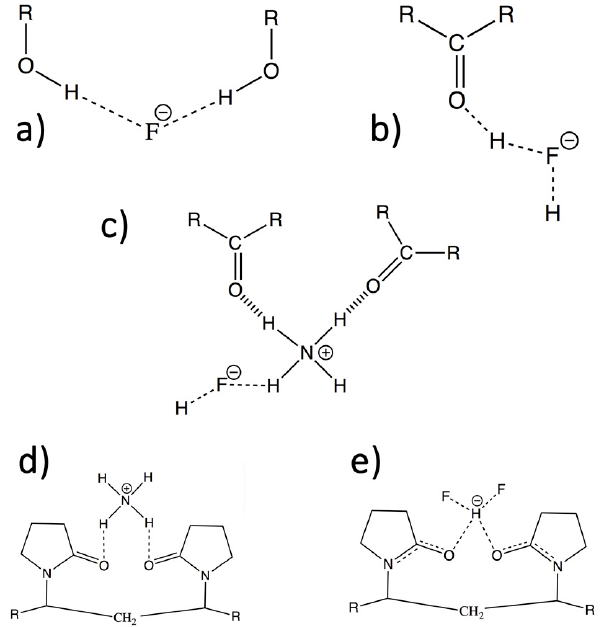
Figure 1. A selection of possible coordination geometries of fluoride ions and ammonium ions to different functional groups: ( a ) Coordination of F − to alcohol groups; ( b ) Coordination of F 2 H − to any kind of C=O; ( c ) Coordination of the ammonium ion to an aldehyde or acetate type of functional group and further coordination to F 2 H − ; and ( d , e ) Example of coordination to polyvinyl pyrrolidone (PVP) with the ammonium group or with the F 2 H − ion.